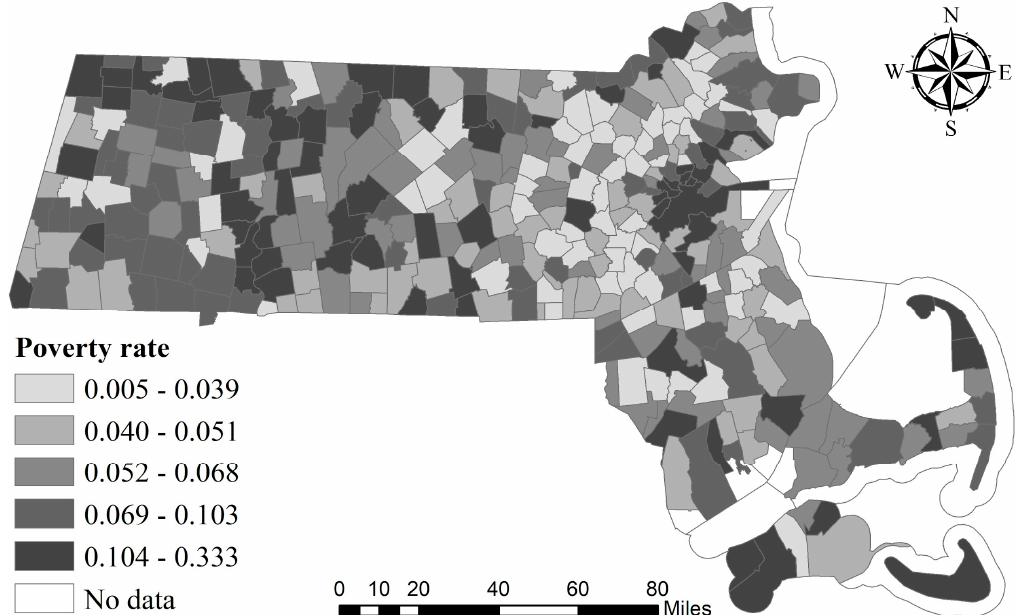
Figure 5. Geographical distribution of poverty rate.